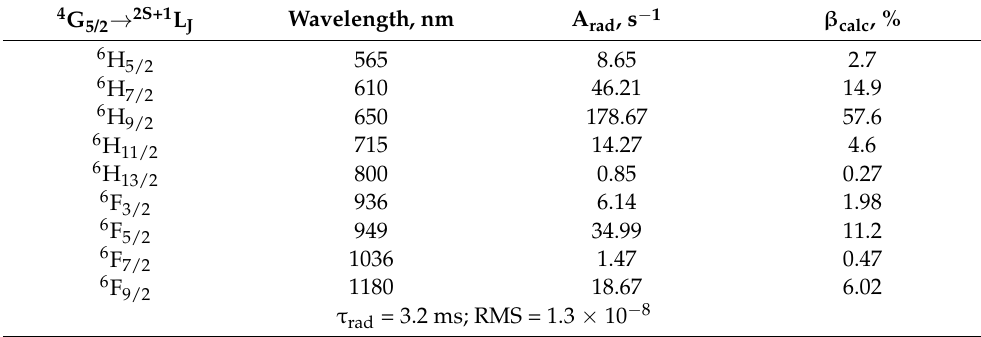
Table 5. Calculated electric-dipole transition probabilities A rad, branching ratios β calc, radiative lifetime τ rad for complex H 3 O[Sm(Q cy ) 4 ].